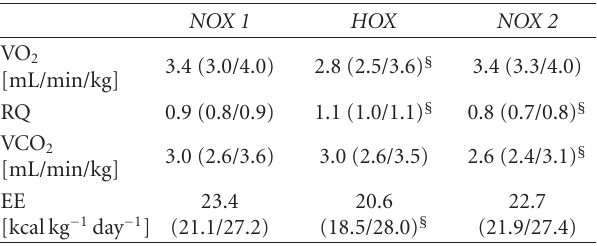
Table 1: Hemodynamic parameters. Table 2: Metabolic